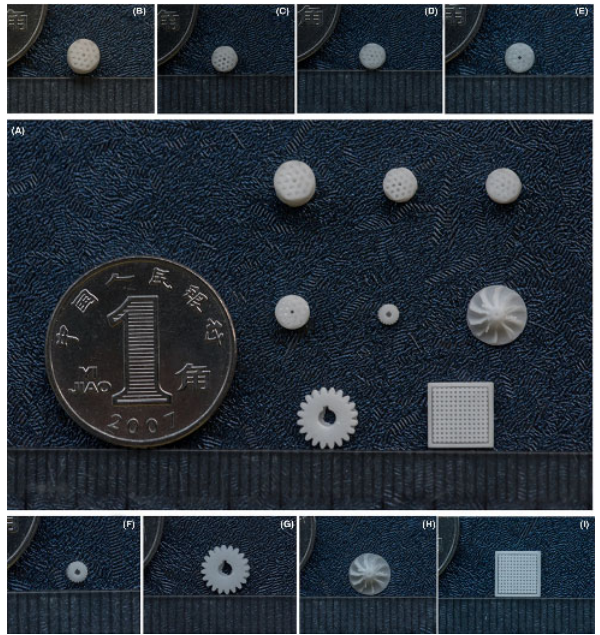
Fig. 5 Alumina and zirconia ceramic micro-components fabricated using stereo-lithography: (B–E) cellular structures with different pore size and helical structure, (F, G) different size micro-gears, (H) turbine micro-rotor, (I) columnar array with pillar diameter of 100–200 μ m. Reproduced with permission from Ref. [86], ©